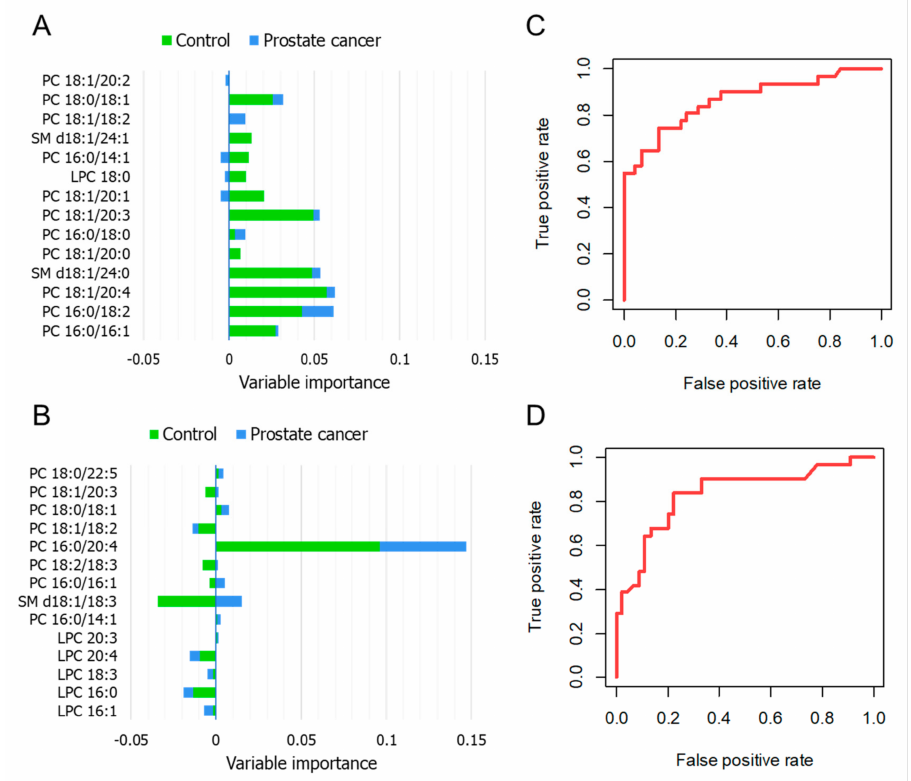
Figure 6. RF analysis—variable importance plot referring to the 14 most relevant features selected from the ESI-QqQ/MS ( A ) and MALDI-ToF/MS ( B ) analysis; ROC curves corresponding to the plotted probabilities calculated from the developed model for the ESI-QqQ/MS ( C ) and MALDI- ToF/MS ( D ) data, when PCa is labeled as the state